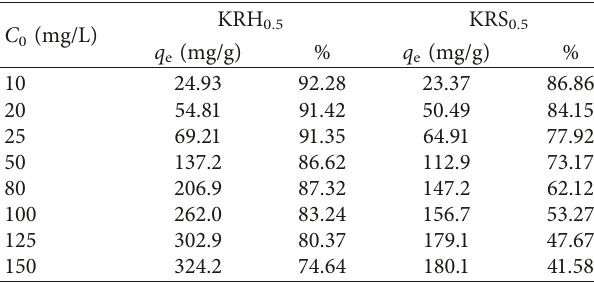
Table 2: Effect of initial concentration of MG on